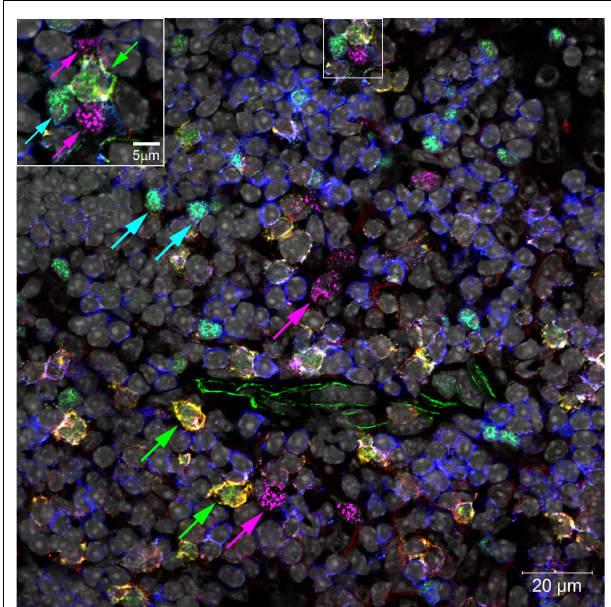
FIGURE 2 | Confocal micrograph of mouse thymic medulla, marking locations of LTi (green arrows),T regs (turquoise arrows), andAIRE + mTECs (magenta arrows) . Inset enlarges an LTi in a cluster with two mTECs and aT reg . Normal thymus sections were stained with fluorescent markers for Ror γ t (green), IL-7R α (Yellow), Foxp3 (turquoise), CD3 (blue), AIRE (magenta), and cell nuclei